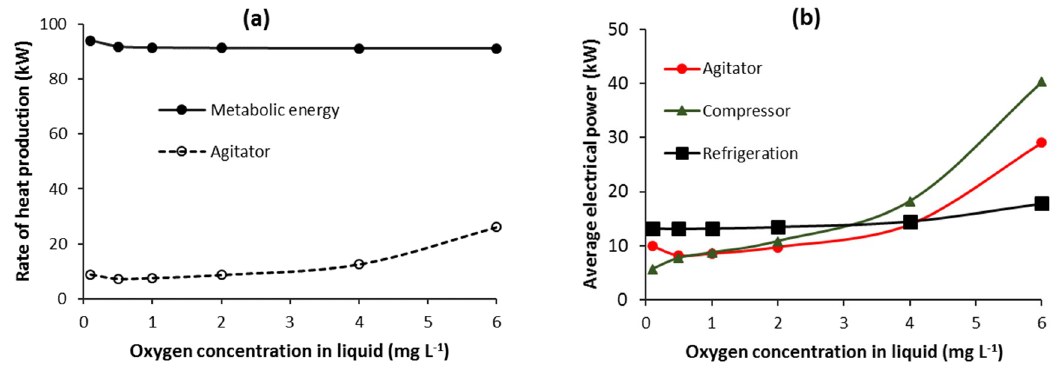
Figure 12. Cooling requirement in batch bioreactor: ( a ) rate of metabolic heat production and agitator heat dissipation; ( b ) comparison of refrigeration, agitator and air compressor average electrical power requirements.